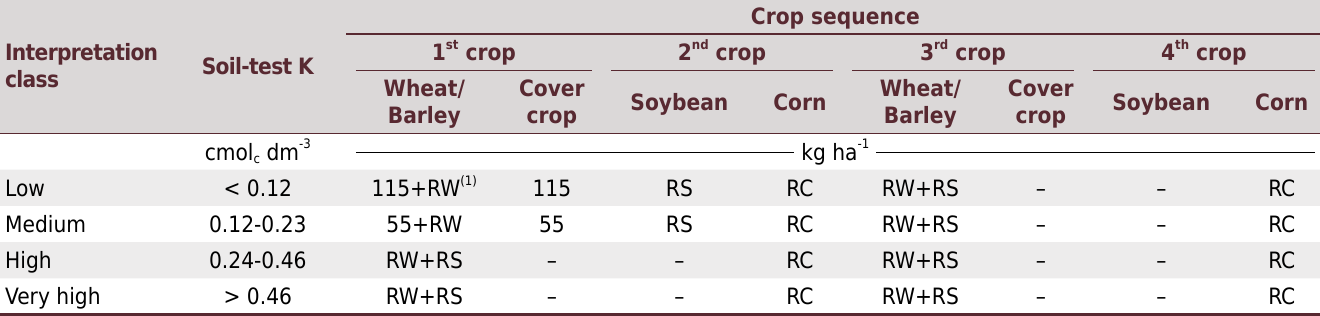
Table 5. K 2 O rates for a sequence of four crops (soybean, corn, wheat, and barley) in rotation on Oxisols in different interpretation K classes under no-tillage in the central-southern region of Paraná